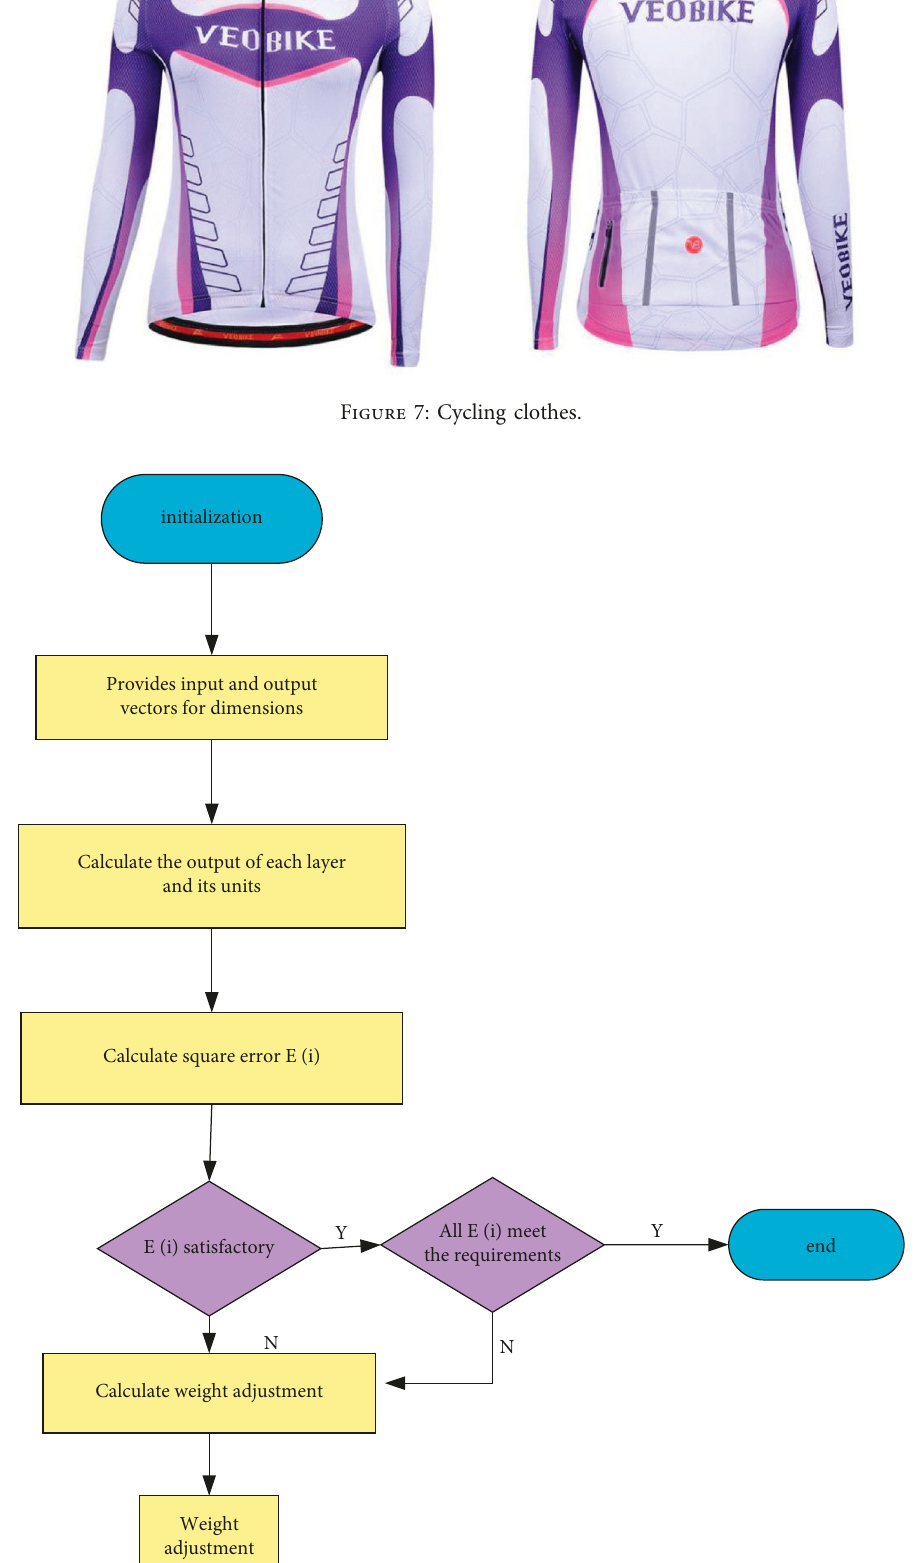
Figure 8: BP algorithm flowchart.